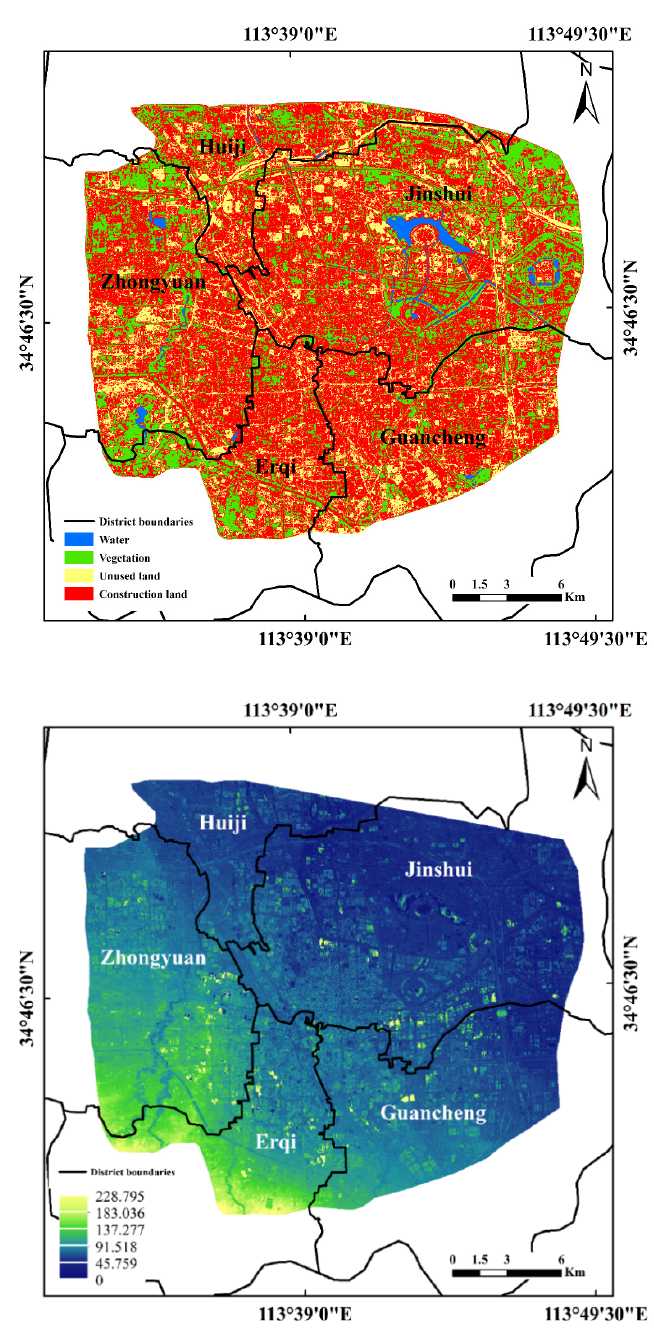
Figure 5. Land use and DSM map of Zhengzhou city, 2017.